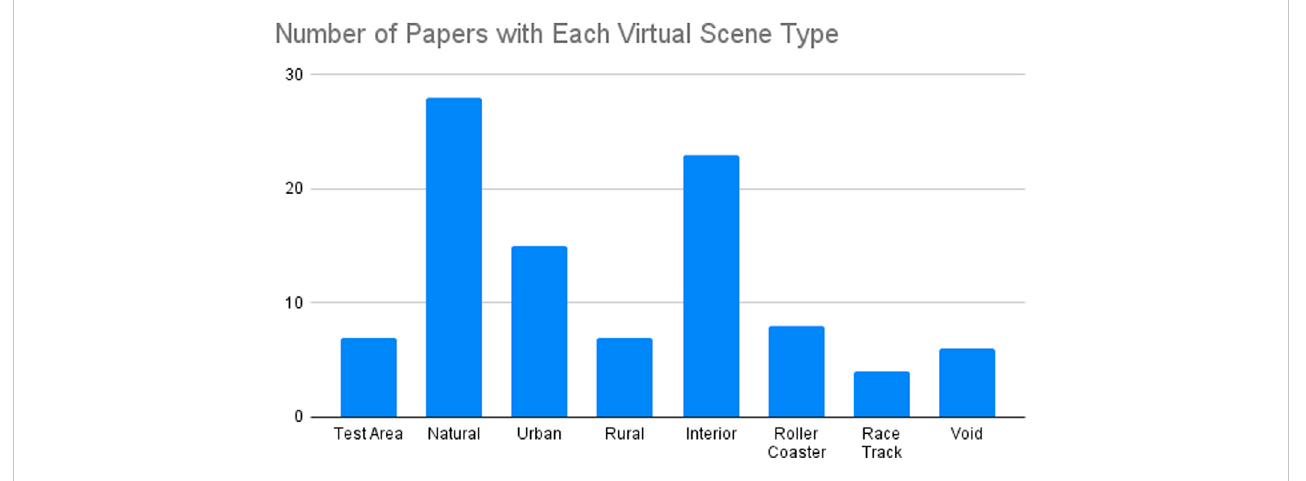
The number of papers featuring each environment